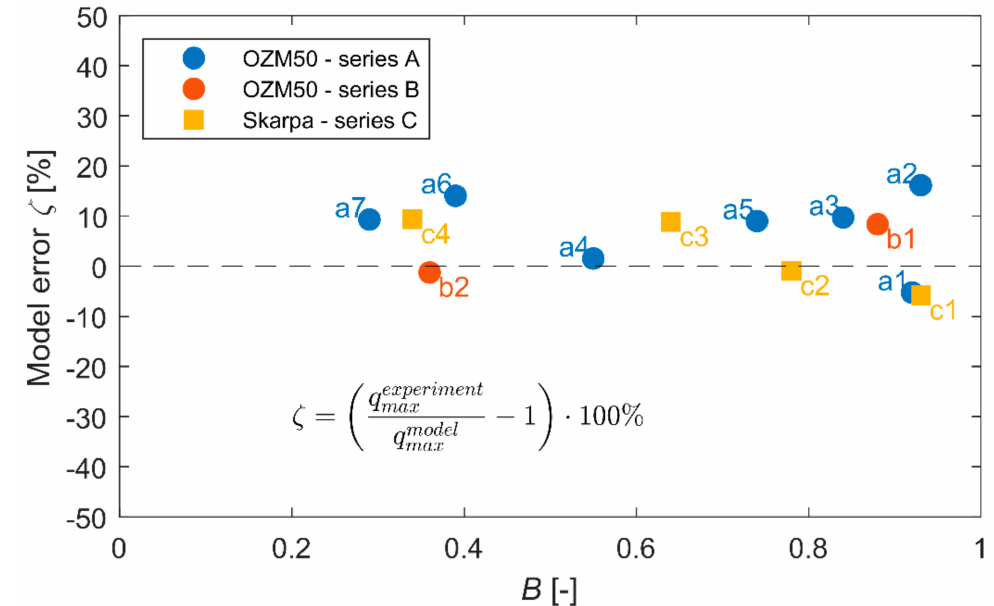
Figure 24. Prediction errors for maximum